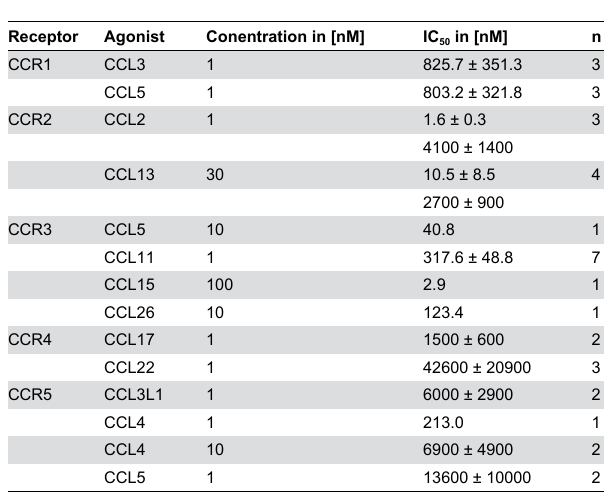
Table 1. CCL18 inhibition of chemotactic responses.